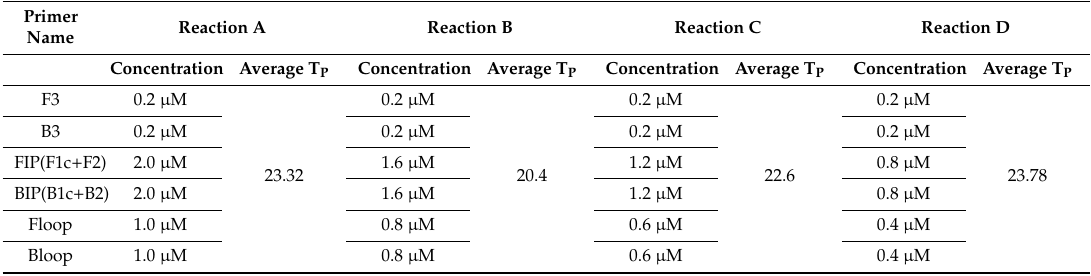
Table 3. E ff ect of RT-LAMP primer concentrations on performance of the assay. T P : Time to